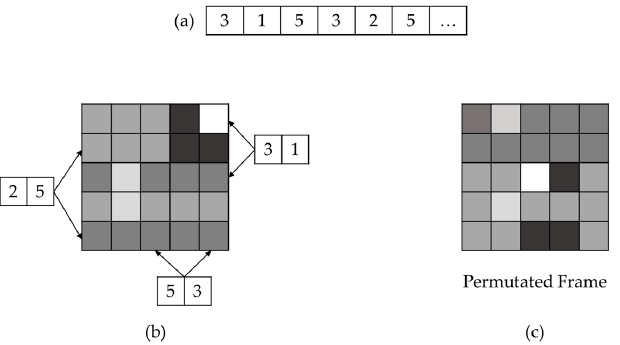
Figure 3. JLVEA encryption module structure and flows.